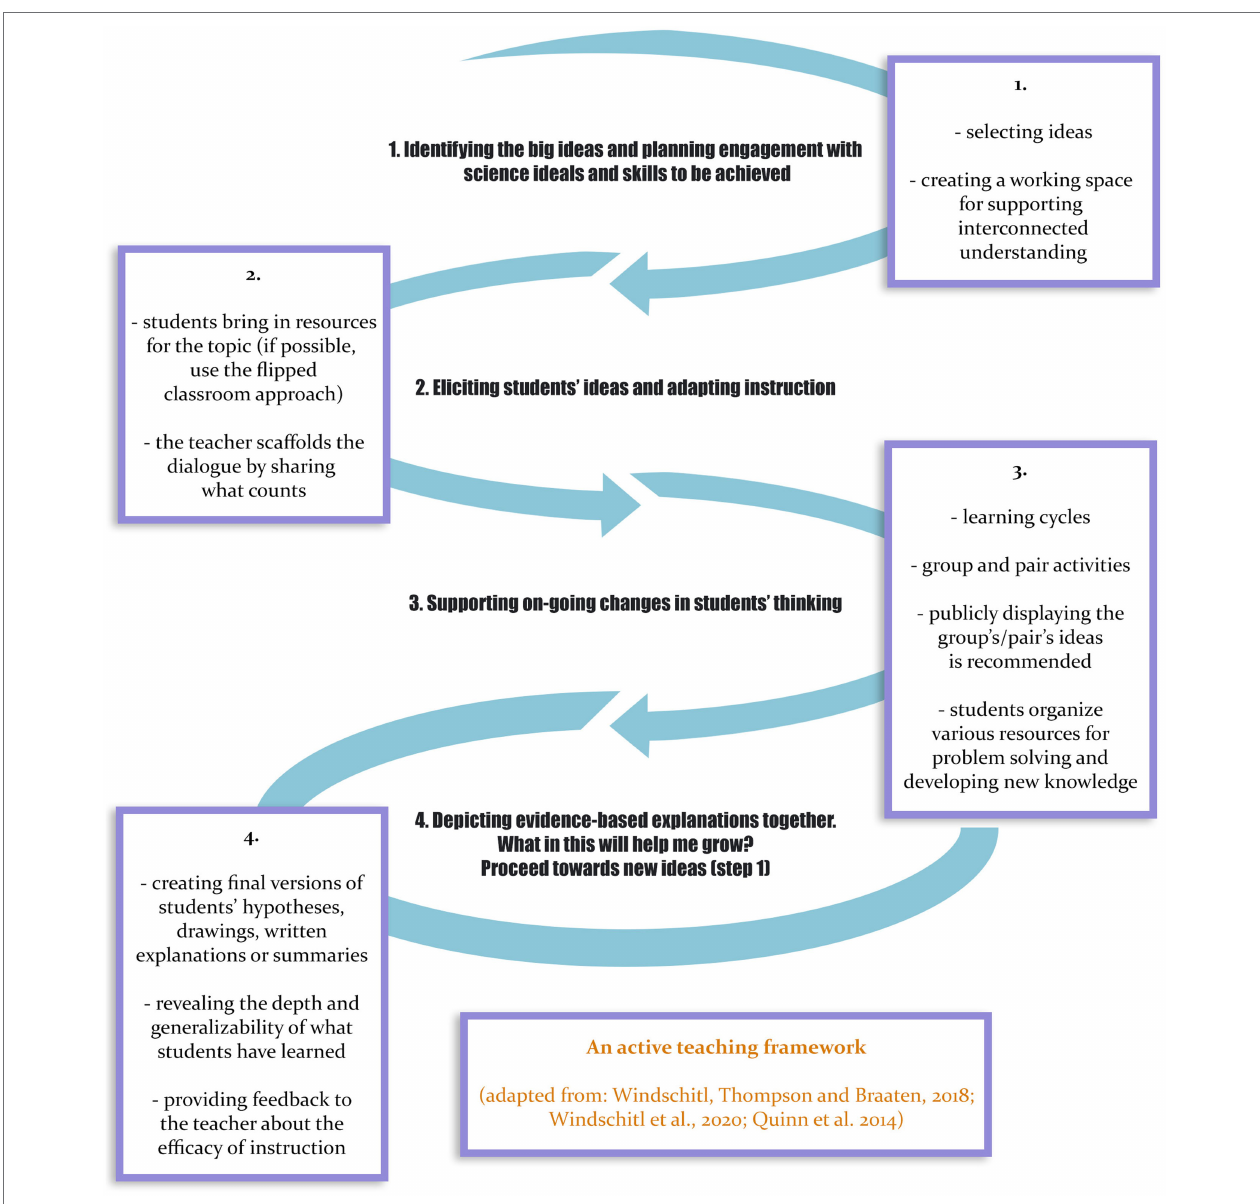
FIGURE 1 | An active teaching